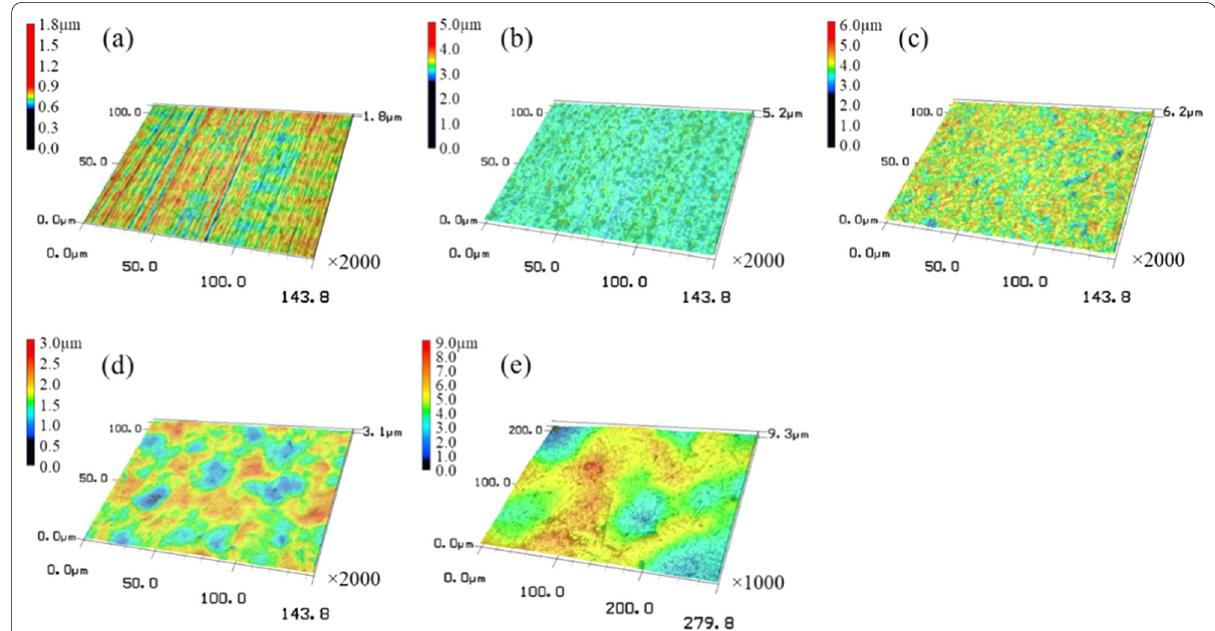
Fig. 1 3D images of control and FPB surfaces. a Control, b FPB-1, c FPB-2, d FPB-3, and e FPB-4